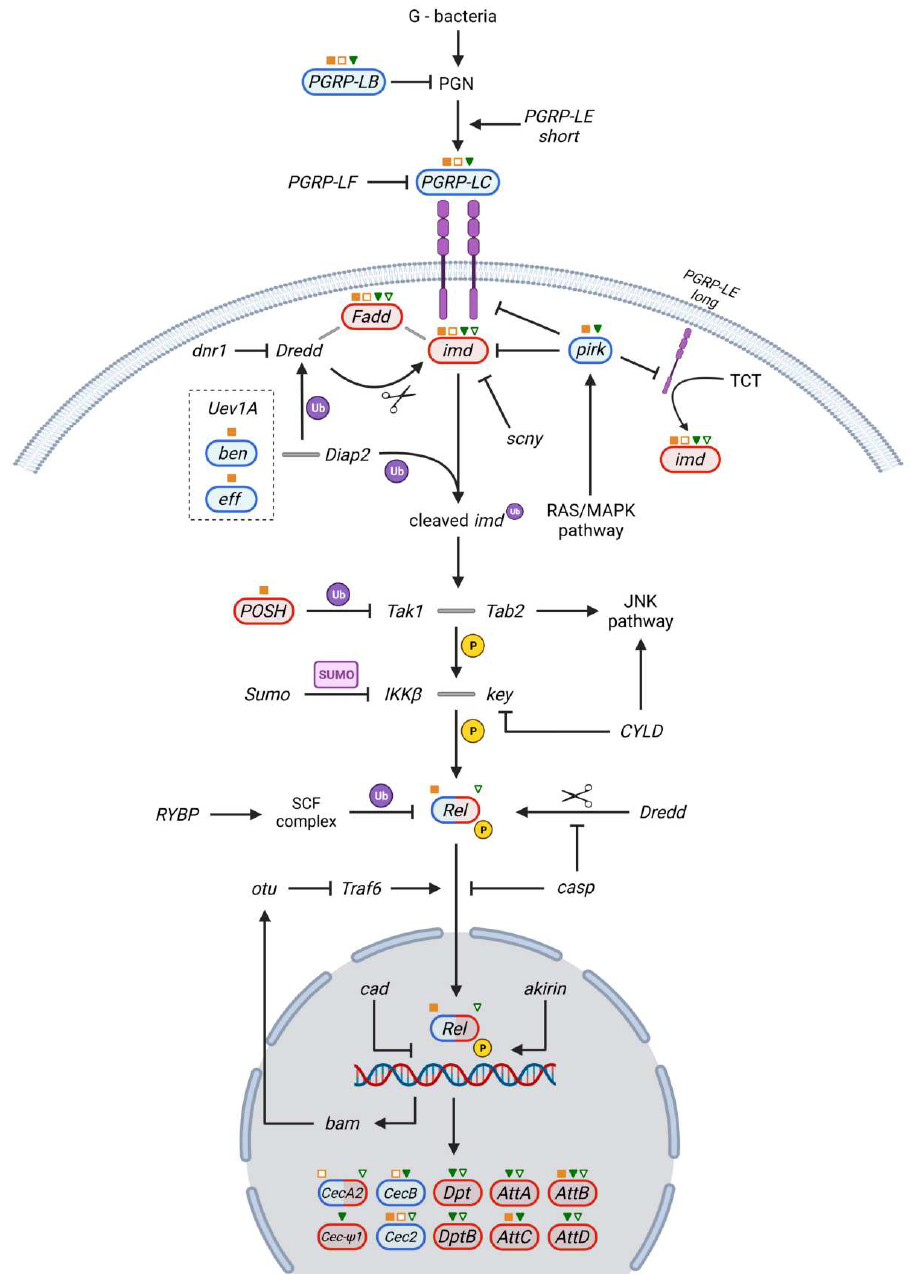
Figure 4. Biochemical model of Imd pathway activation in D. melanogaster cells as a response to Gram-negative (G-) infection. The observed gene expression change corresponding to the experiment conditions and mutants is shown in blue (upregulation) or red (downregulation). With orange-filled or orange-bordered squares we indicate that the pinpointed gene significantly varies its expression in infected and, respectively, uninfected γCOP 14a /γCOP 14a males. With green-filled or green-bordered triangles we indicate the genes that significantly vary their expression in infected and, respectively, uninfected γCOP S057302 /TM6B males. Unmarked components of the pathway did not show any statistically significant expression change. Created with BioRender.com (24 February 2022).